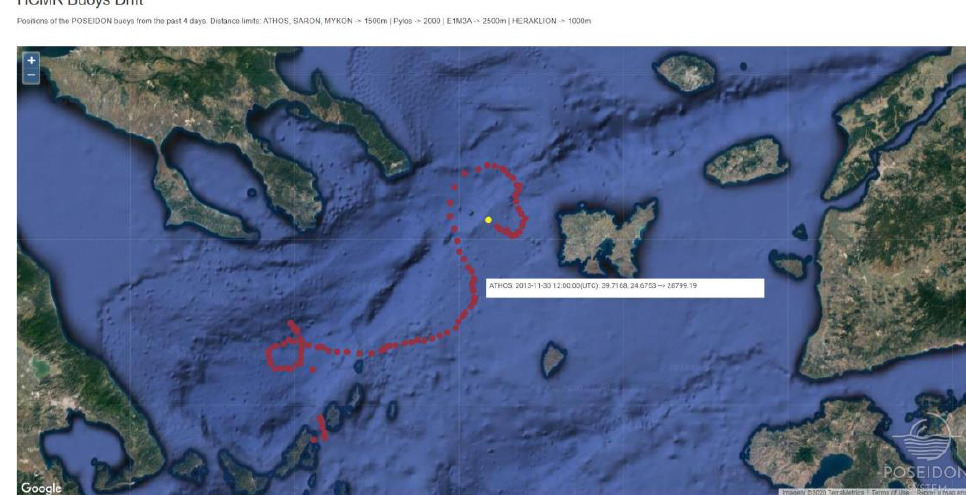
Figure 9. Drifting incident for the ATHOS buoy, December 2013.